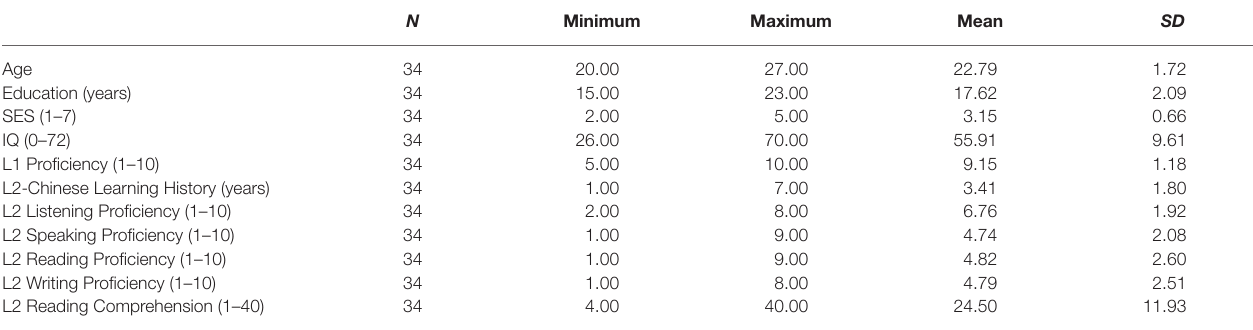
TABLE 1 | Descriptive data of participants’ background information.